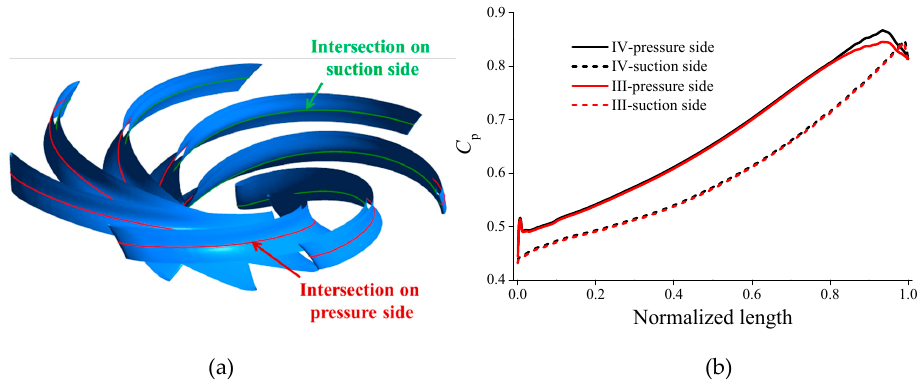
Figure 15. Pressure distribution. ( a ) Intersections of blades and the middle spanwise hub-to-shroud surface and ( b ) time averaged pressure distribution at two conditions (locations of 0 and 1 represent the entrance and the exit of the impeller, respectively).